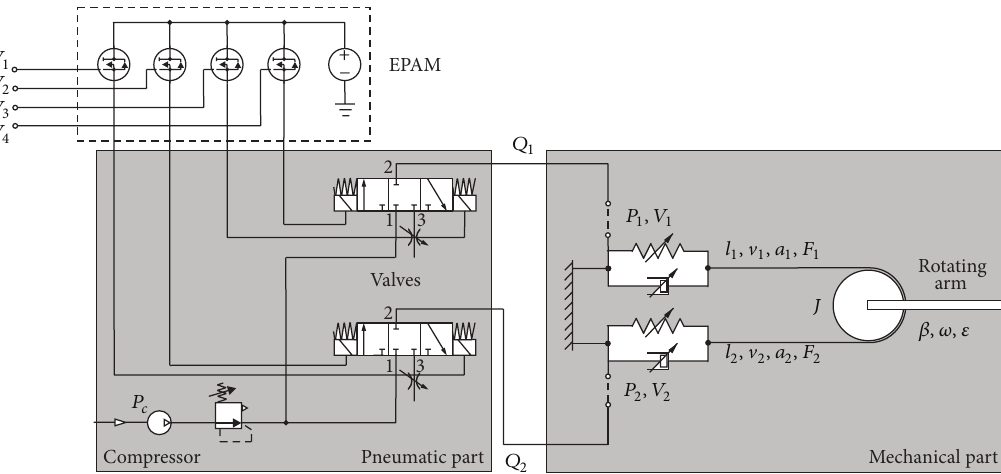
Figure 2: Physical representation of PAM-based actuator with modeled parts being shown in grey color (in the scheme, 𝑃 𝑐 is compressor pressure [Pa], 𝑄 𝑖 is volume flow rate [m 3 ⋅ s −1 ], 𝑃 𝑖 is muscle pressure [Pa], 𝑉 𝑖 is muscle volume [m 3 ], 𝑙 𝑖 is muscle length [m], V 𝑖 is muscle velocity [m ⋅ s −1 ], 𝑎 𝑖 is muscle acceleration [m ⋅ s −2 ], 𝑖 is muscle index, 𝛽 is joint angle [deg], 𝜔 is joint angular velocity [rad ⋅ s −1 ], and 𝜀 is joint angular acceleration [rad ⋅ s −2